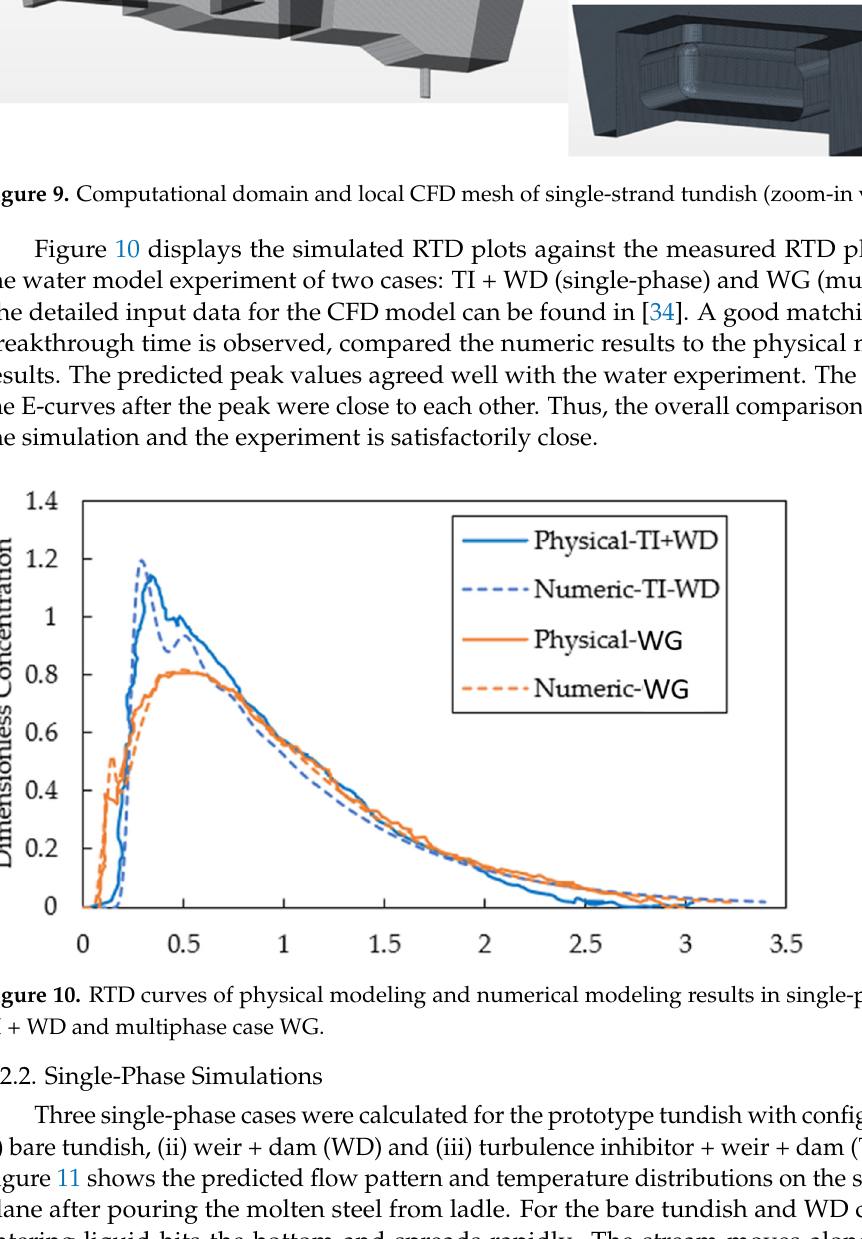
Figure 9. Computational domain and local CFD mesh of single-strand tundish (zoom-in view).